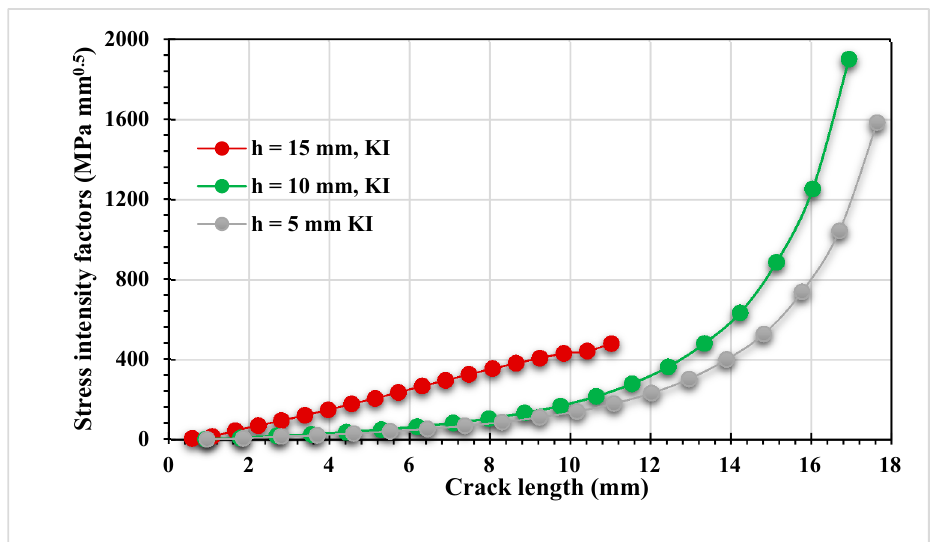
Figure 14. Evaluated results of K I for three pre-crack positions.